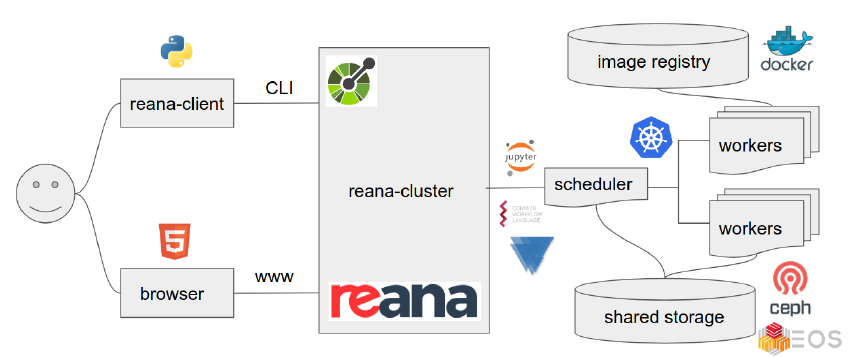
Figure 2: An overview of the REANA platform. The user can interact with the platform via a command line and Web clients. The platform dispatches users’ requests to workflow engines and runs necessary tasks on the containerised cloud. The workflow tasks share the same workspace throughout the